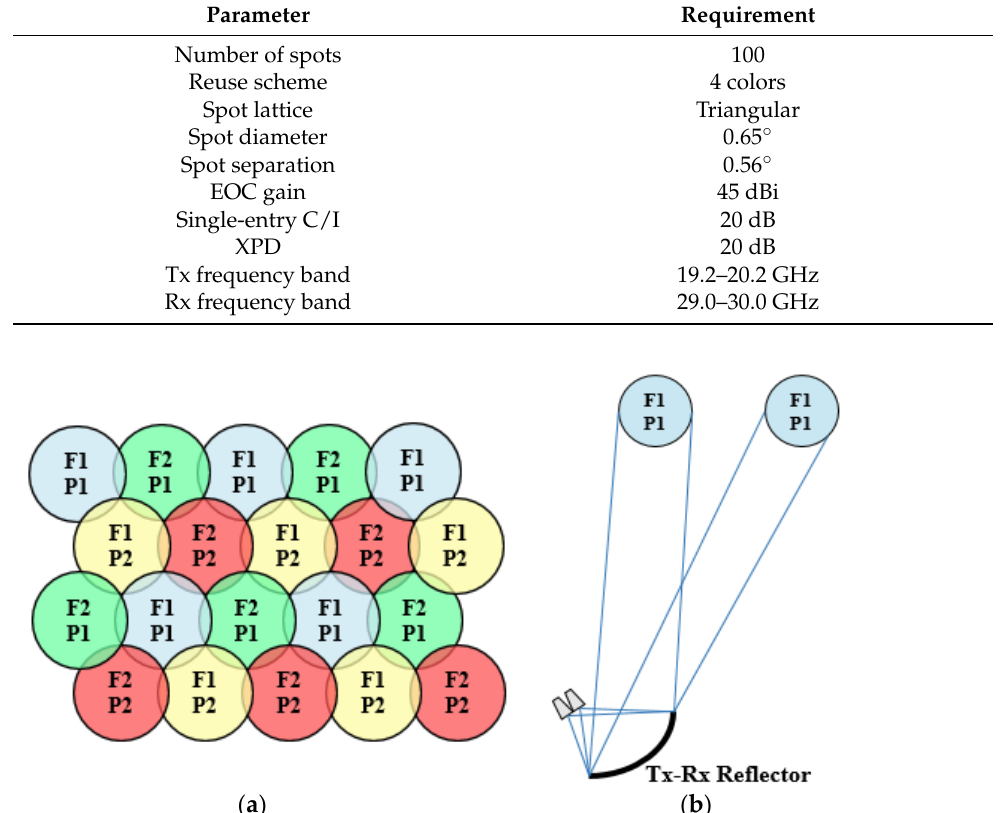
Table 1. Antenna system requirements.